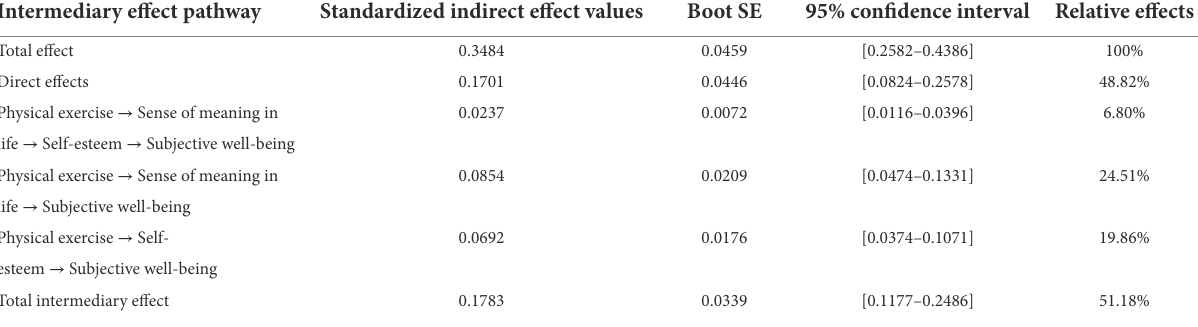
TABLE 4 Chain mediation effect test between sense of meaning in life, self-esteem in physical exercise and subjective well-being. Intermediary effect